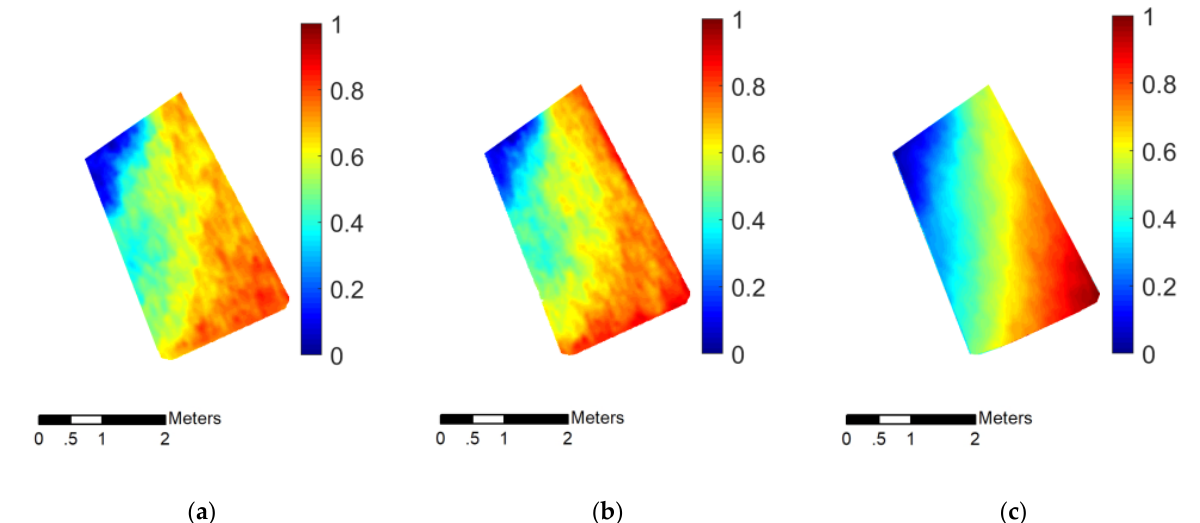
Figure 22. Reconstruction results of ROI 2 by three methods ( a ) SGM interpolation result, ( b ) PPS interpolation result, ( c ) PSOP result for orthorectified images. Table 6. Quantitative measures of DEMs by three methods for Yutu-2